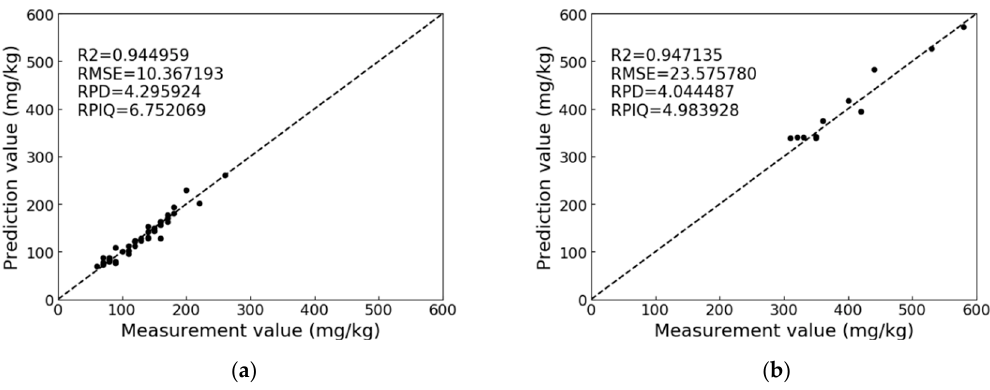
Figure 9. Scatter plots of best models with di ff erent concentrations of samples; ( a ) AdaBoost with low concentration samples; ( b ) Gradient boosted regression trees(GBRT) with high concentration